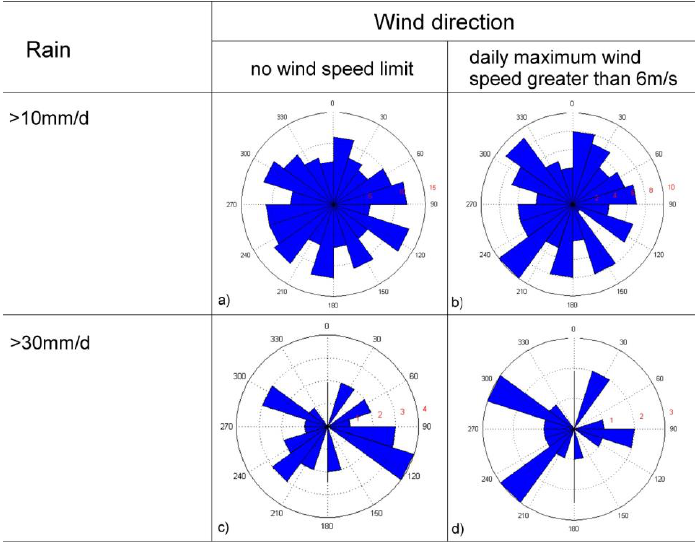
Figure 7. Wind directions during events with: ( a ) rainfall rates greater than 10 mm/d; ( b ) rainfall rates greater than 10 mm/d and daily maximum wind speeds greater than 6 m/s; ( c ) rainfall rates greater than 30 mm/d; and ( d ) rainfall rates greater than 30 mm/d and daily maximum wind speeds greater than 6 m/s. The number of days is shown in red.